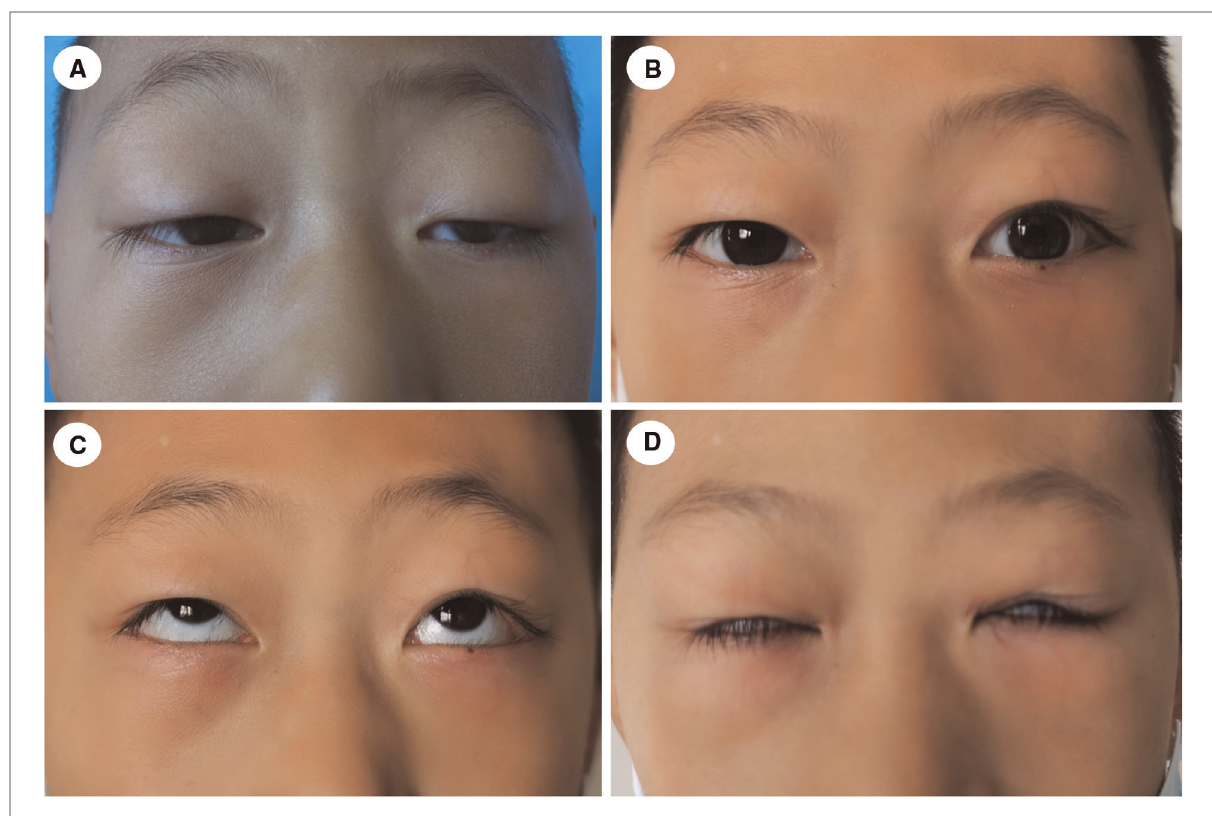
FIGURE 6 A 9-year-old boy with congenital blepharoptosis OU. ( A ) preoperative appearance; ( B ) twelve months after CFS+LM suspension; ( C,D ) eye movement was normal and lagophthalmos was